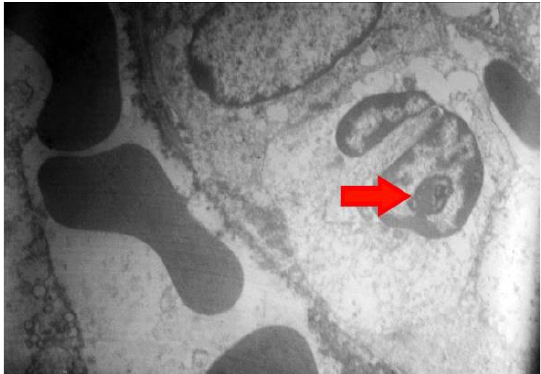
Fig. 4. Electron microscopy showed the presence of nucleolus in the nucleus of swollen degenerated endothelial cells; (Original magnification ×1600). (Courtesy of Dr. Mitra Rezai, Shahid Beheshti University of Medical Sciences)